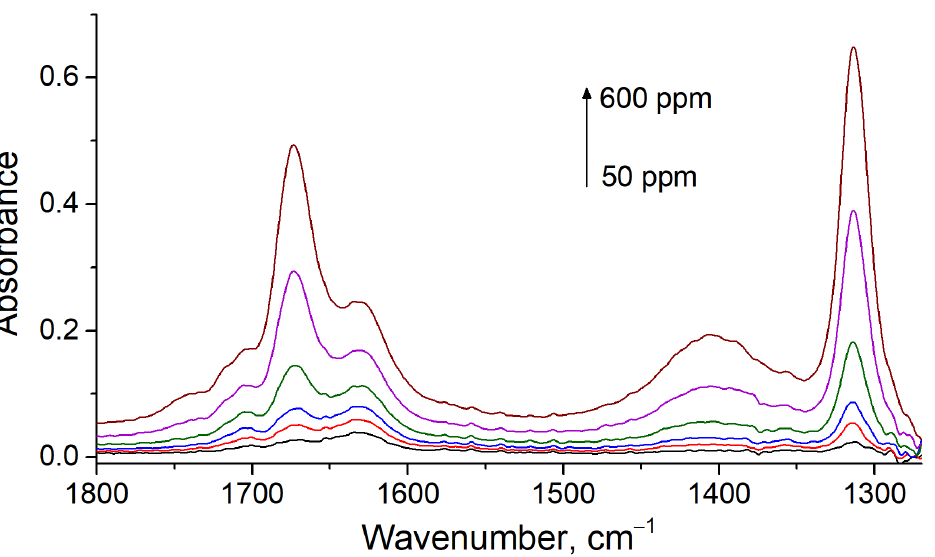
Figure 6. FTIR spectra of NO 2 detected by DeAl-BEA: 50 ppm (black), 75 ppm (red), 100 ppm (blue), 200 ppm (green), 400 ppm (purple), 600 ppm (dark red).